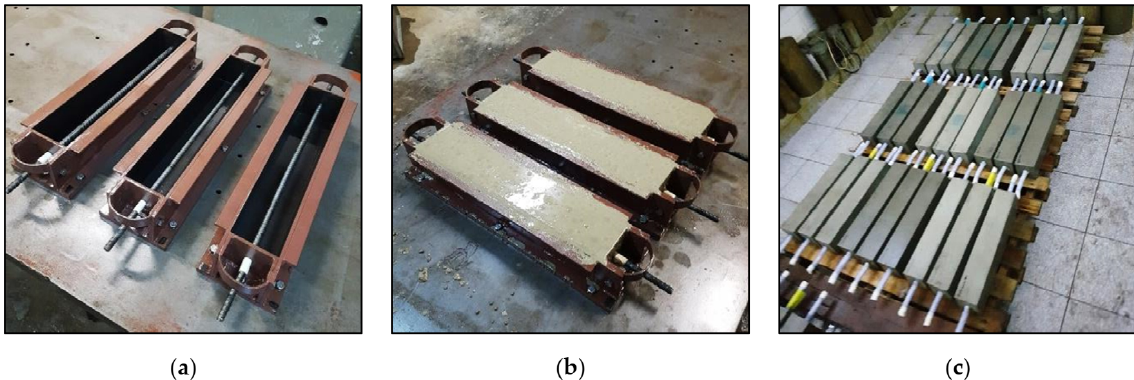
Figure 2. Production of reinforced elements: ( a ) Preparation; ( b ) Casting; ( c )